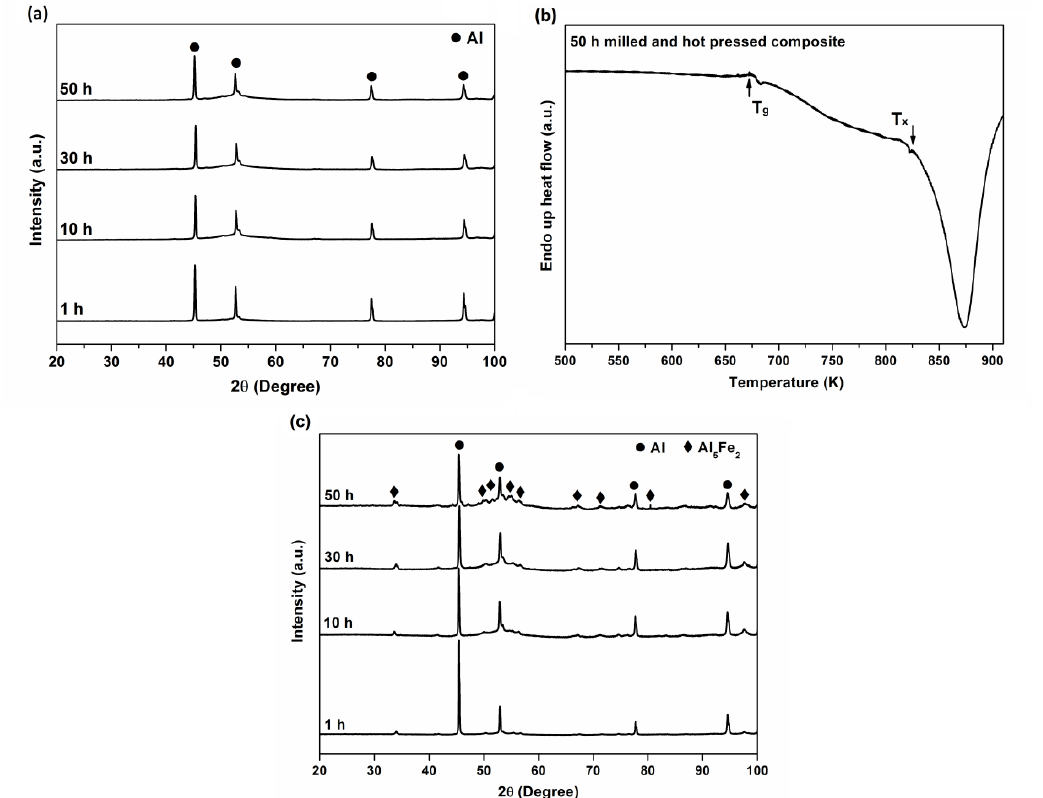
Figure 3. XRD patterns and DSC scan of the milled and consolidated samples: ( a ) XRD patterns of the hot pressed, ( b ) DSC scan of the 50-h milled and hot pressed and ( c ) XRD patterns of the hot pressed and hot extruded